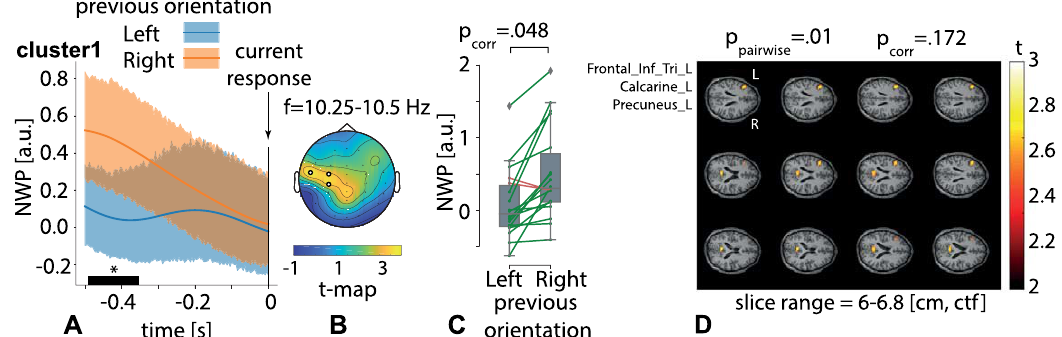
Figure 7. Significant cluster as the result of NWP comparison during the right-oriented LA stimuli processing following the right- and left-oriented stimuli on the 0.5-s interval time-locked to the behavioral response (vertical solid line). The orange and blue curves ( A ) show NWP evolution (group means and 95% CI) in this cluster during the right-oriented LA stimuli processing following the left-oriented and right-oriented stimuli. The topogram ( B ) reflects the t -value and the channels demonstrating a significant change of NWP between analyzed conditions on the EEG sensor level. The box-plot ( C ) illustrates NWP in this cluster averaged over the time interval, frequency band, and channels. The slice-plot ( D ) reflects the t -value for the voxels demonstrating a significant change of the source power. p corr is corrected for multiple comparisons via the cluster-based test with the Monte-Carlo randomization technique.